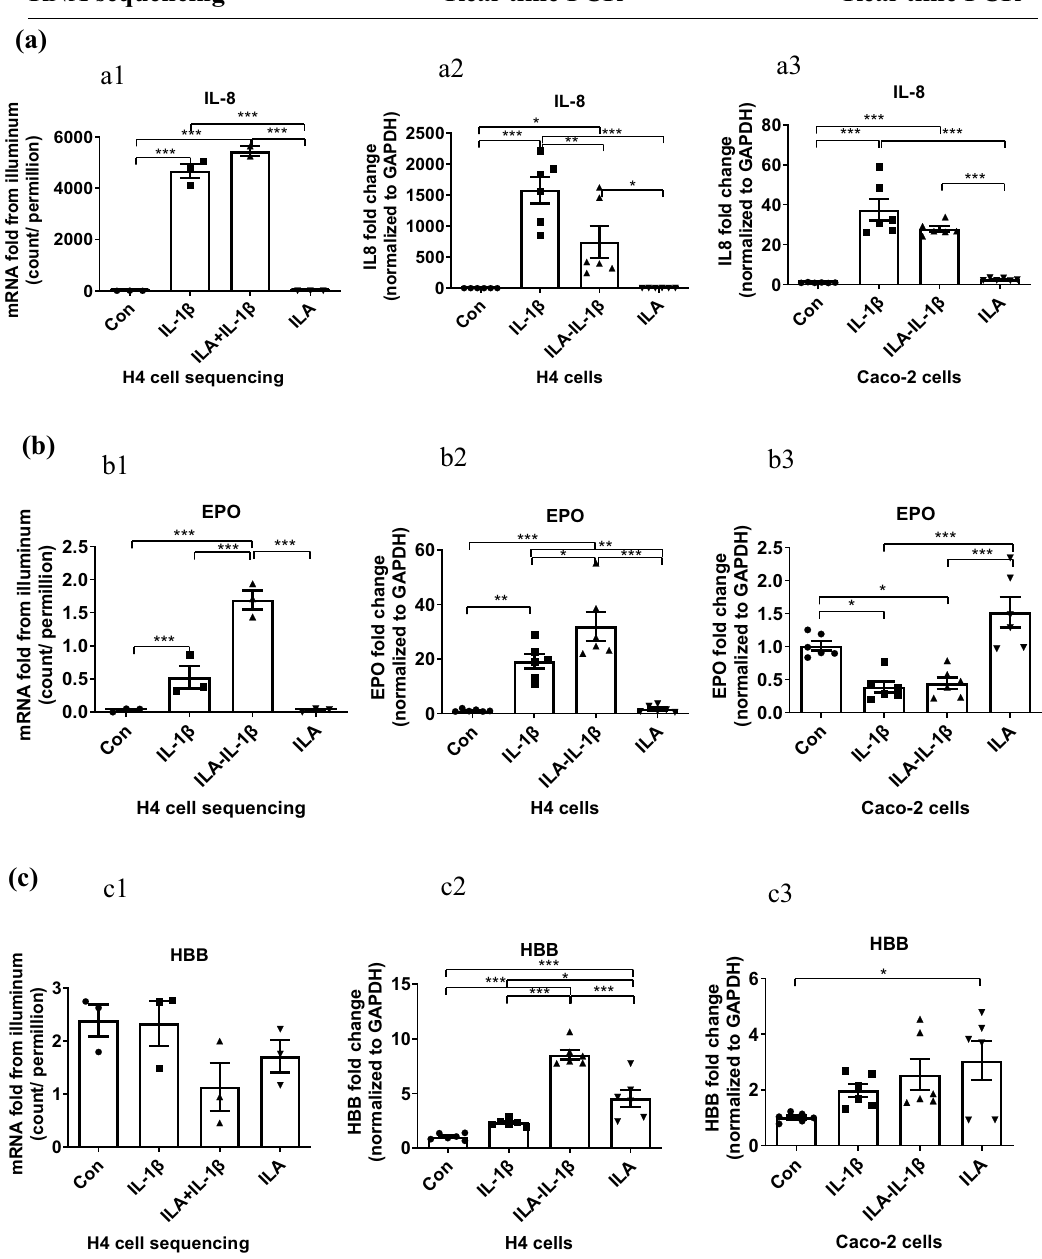
Figure 2. The anti-inflammatory potential of ILA is different in immature and mature enterocytes. ( a ) ILA inhibited IL-1β-induced IL-8 mRNA expression in both H4 (a2) and Caco2 (a3) cells by real time PCR, but not by the Illumina method (a1). ( b ) The effects of ILA on anti-NEC inflammatory factor EPO mRNA expression in H4 cells (b1 and b2) and Caco2 cells (b3). ( c ) The impact of ILA on anti-inflammatory factor HBB mRNA expression in response to IL-1β in H4 (c1, c2) and Caco2 (c3) cells. RNA sequencing analysis in H4 cells by using Illumina assay (a1, b1, and c1), the validation of RNA sequencing was conducted by qRT- PCR in H4 cells (a2, b2, and c2) and compared with Caco-2 cells (qRT-PCR)(a3, b3, and c3). H4 or Caco-2 cells were pretreated with ILA before IL-1β stimulation the mRNA levels were detected by RNA sequencing or real time PCR. Data are represented as the mean ± SEM (n = 3 for RNA sequencing, n = 6 for q-RT-PCR). Real time PCR represented one of two independent experiments. One-way ANOVA and Tukey post hoc tests were used for statistical analysis. Differences were considered significant at * p < 0.05, ** p < 0.01, *** p < 0.001. IL-8, interleukin 8; EPO, erythropoietin; HBB, hemoglobin subunit